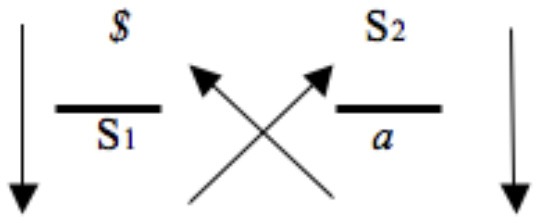
Capitalist discourse (based on: Lacan, 1972, p. 40).